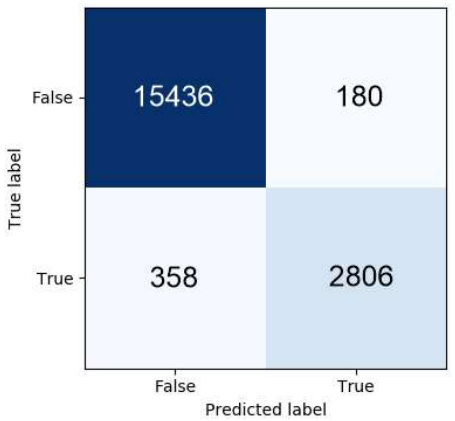
Figure 6. Confusion matrix of the classifier based on model 12.